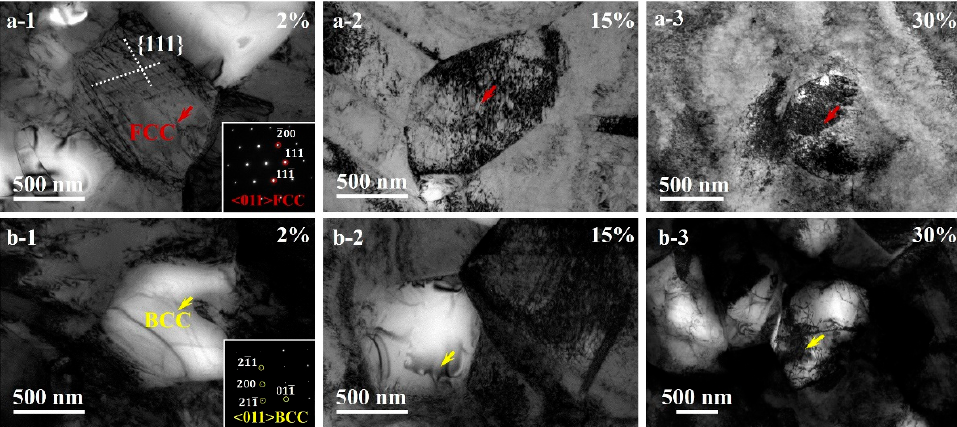
Figure 10. TEM observations for the HS 2 sample showing deformation mechanisms in the UFGs of austenite phase: ( a-1 ) 2%; ( a-2 ) 15%; ( a-3 ) 30%. TEM observations for the HS 2 sample showing deformation mechanisms in the grains of BCC phase at varying interrupted tensile strain: ( b-1 ) 2%; ( b-2 ) 15%; ( b-3 ) 30%.